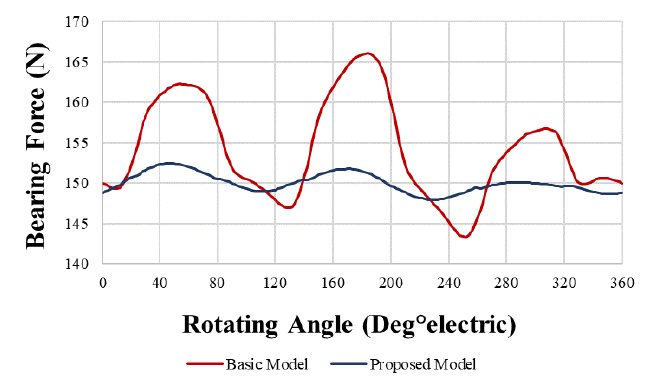
Figure 28. Bearing force waveform of basic and proposed models.